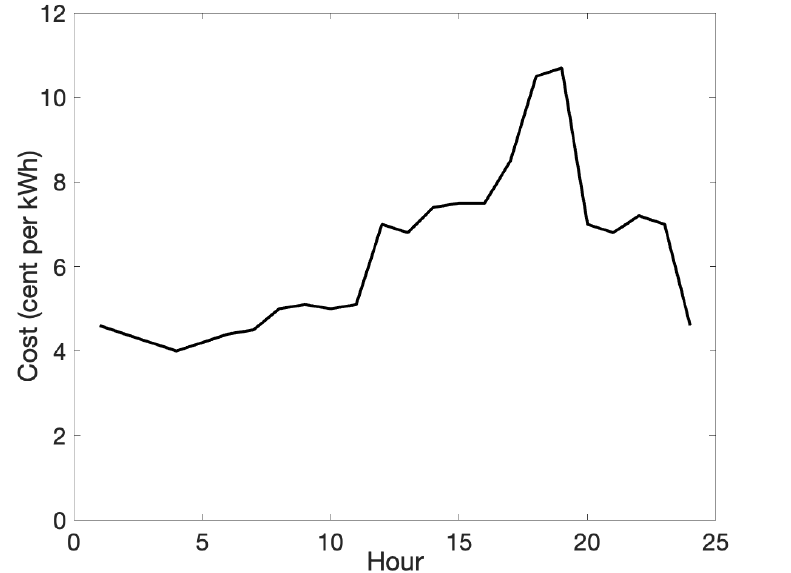
Figure 2. Cost function